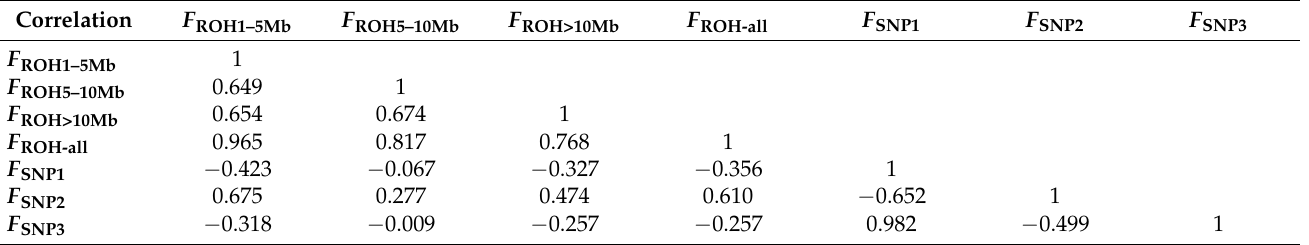
Table 2. Correlation coefficients (lower panel) among seven types of inbreeding coefficient estimates ( F ROH-all , F ROH1–5Mb , F ROH5–10Mb , and F ROH>10Mb , F SNP1 , F SNP2 , and F SNP3 ).